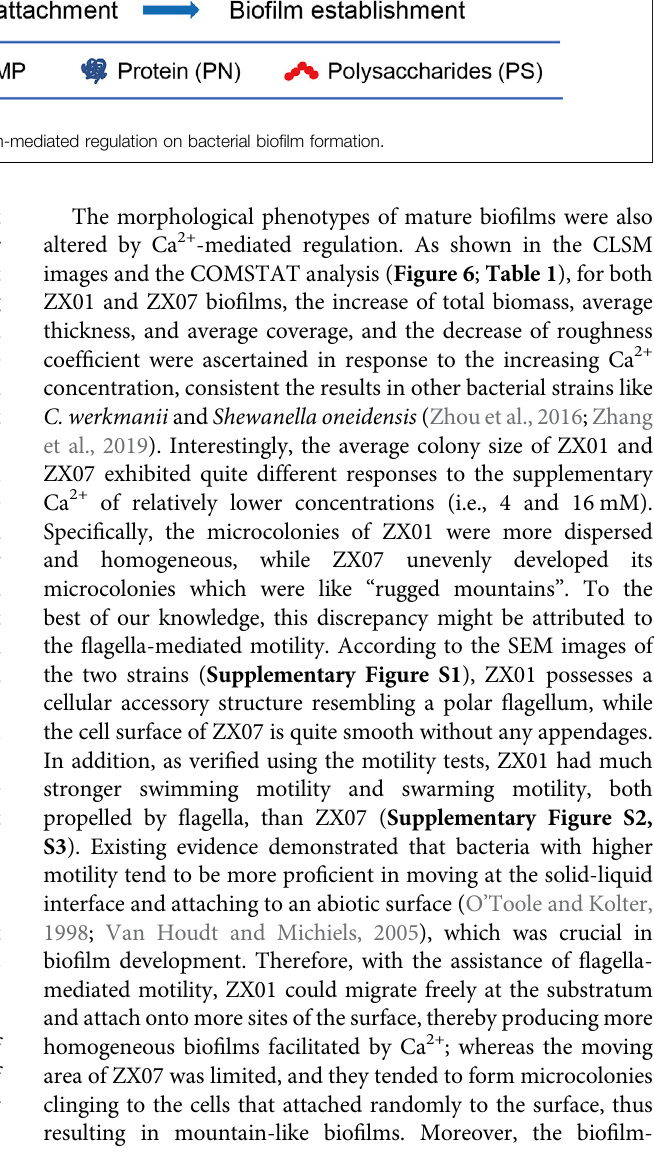
Frontiers in Environmental Science |